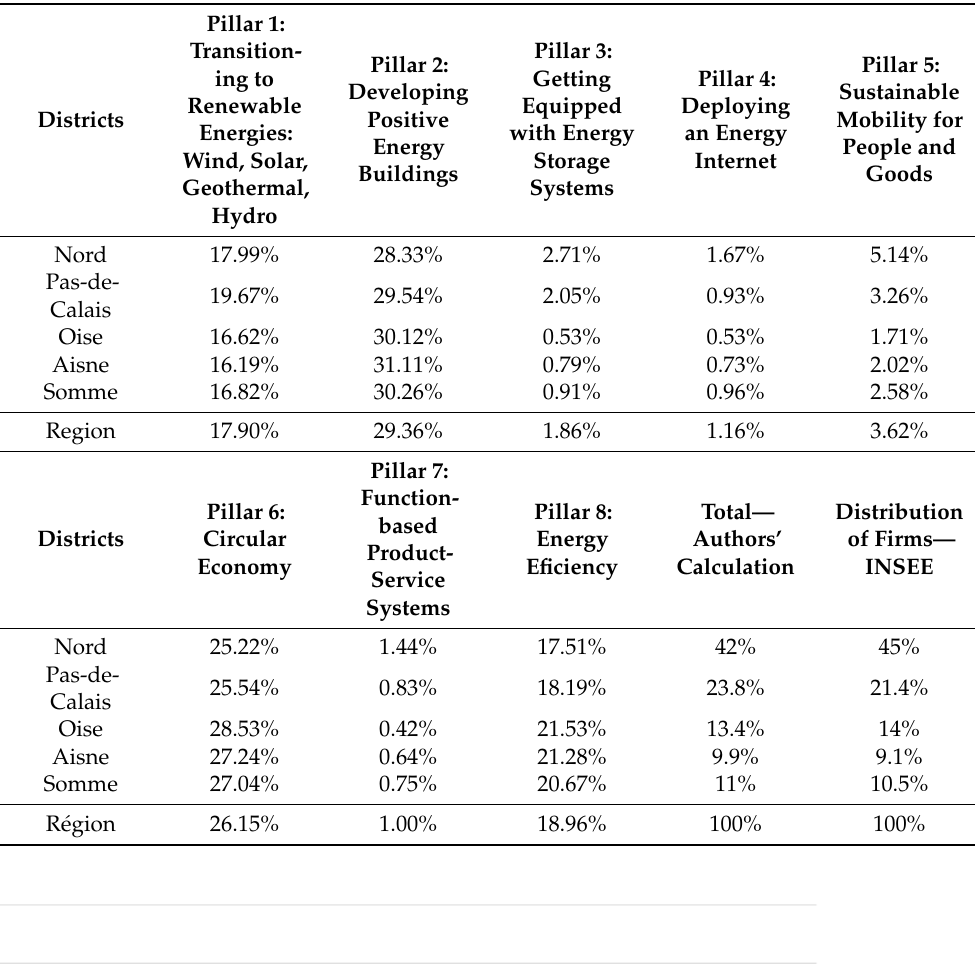
Table 2. Distribution of firms by pillar and districts.